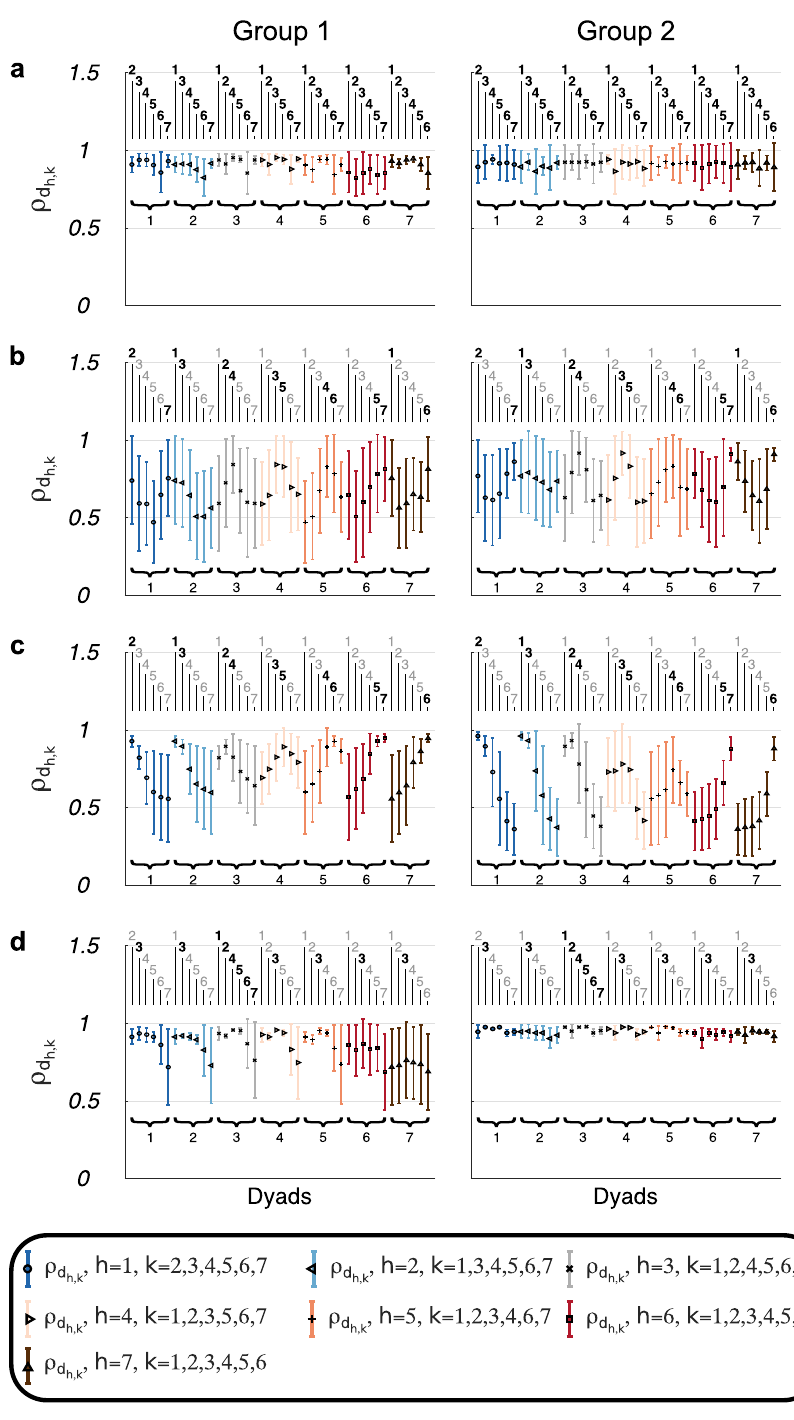
Figure 3. Dyadic synchronisations indices observed experimentally. Mean (symbol) and standard deviation (error bar) over the total number of trials of the dyadic synchronisation index ρ panel) and Group 2 (right panel) in Complete ( a ), Ring ( b ), Path ( c ) and Star graph ( d ) are presented (the respective interaction patterns are shown in Fig. 2). Different symbols and colours refer to pairs related to different players. In each panel, the black subscripts on the bottom represent h , whereas those on the top represent k (bold black for visually connected pairs, grey for uncoupled pairs). For each participant of both groups and in all the implemented topologies, the highest mean values are obtained for the visually connected